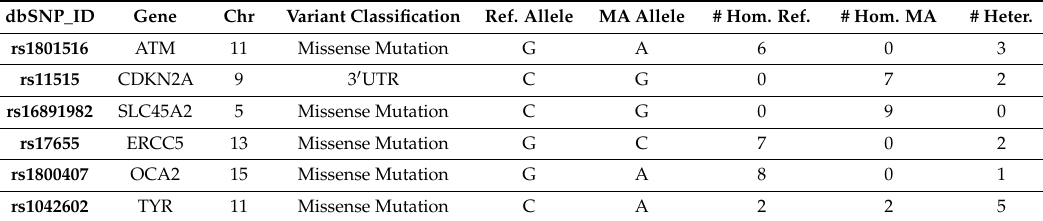
Table 2. Germ-line single nucleotide polymorphisms (SNPs) putatively associated with melanoma, based on genome-wide association studies (GWAS) and MelGene